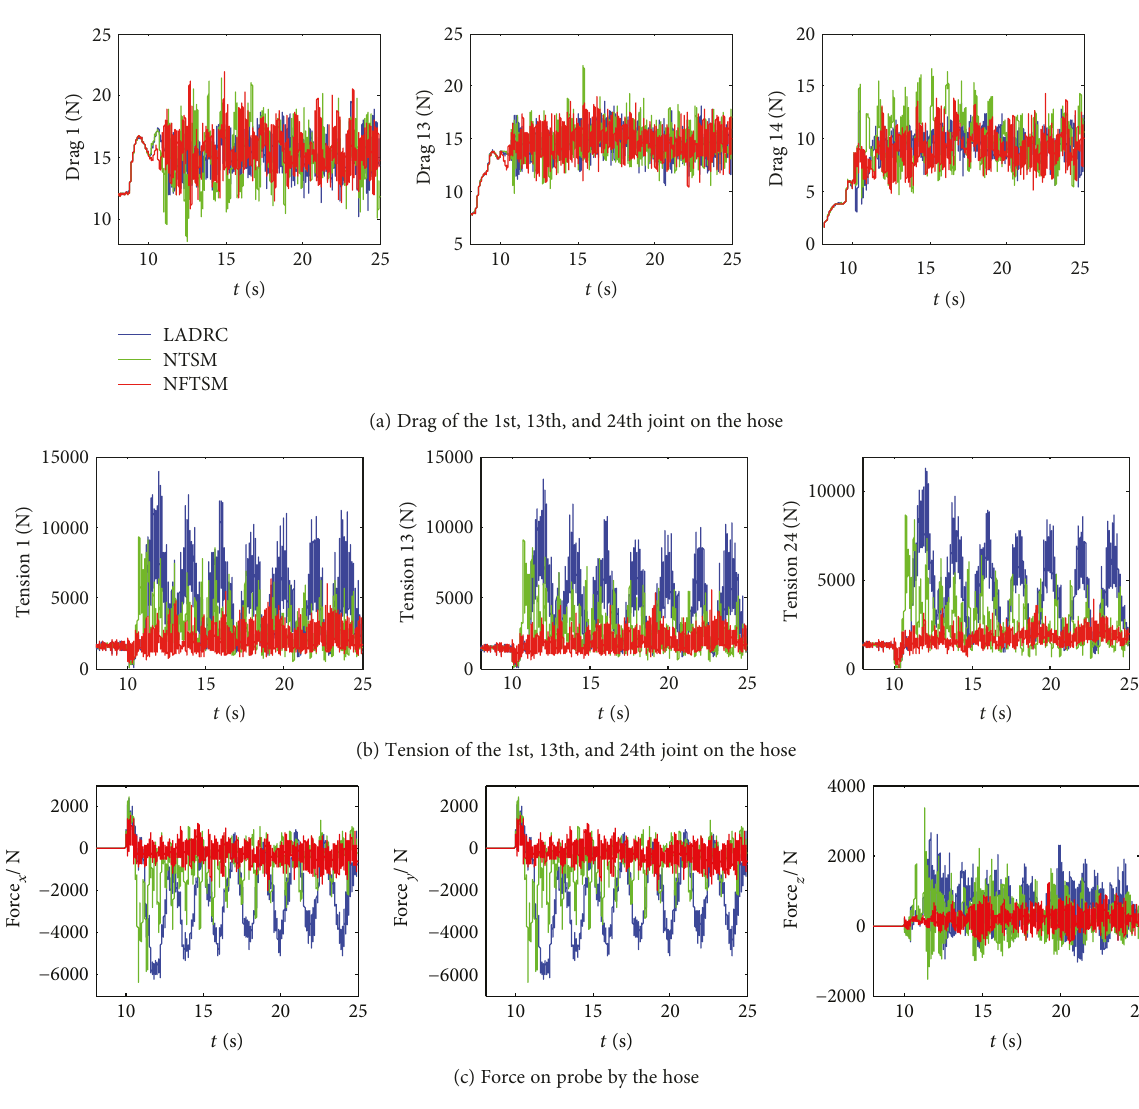
Figure 10: Forces on hose and probe by di ff erent vibration suppression schemes.